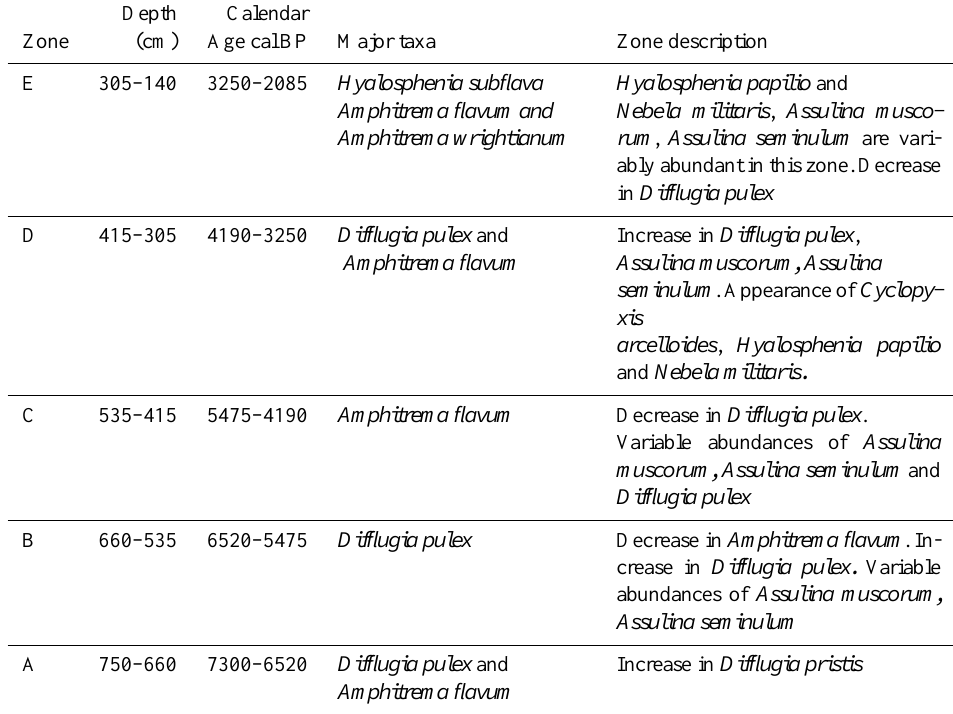
Table 3. Descriptions of testate amoebae zones. Details on testate amoebae assemblage are given in Beghin et al.